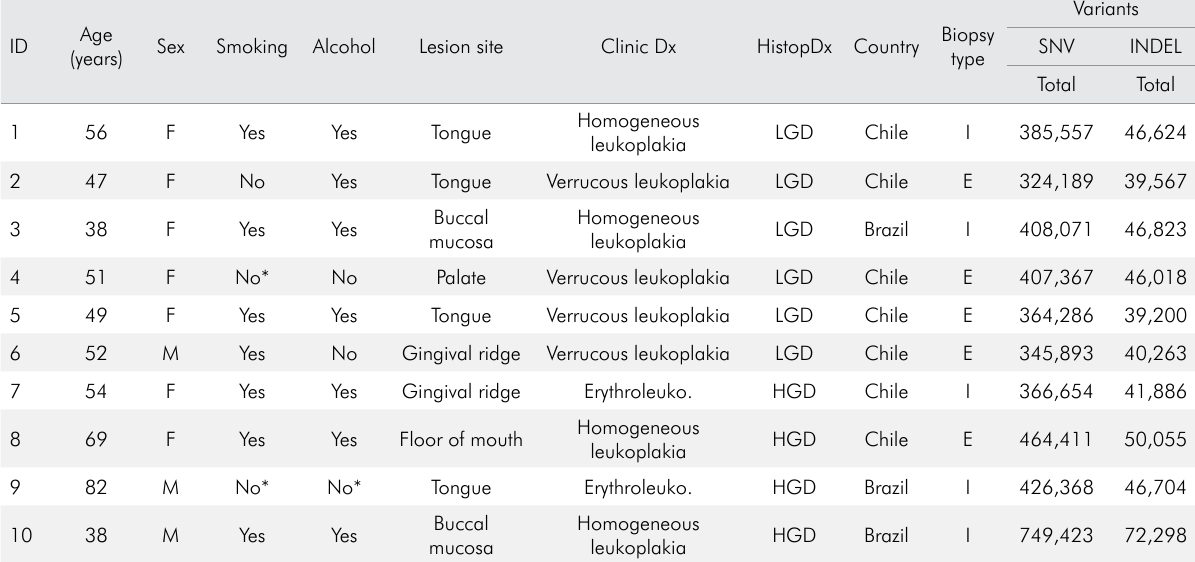
Table. Summary of patient characteristics, histopathological diagnosis, and total variants per sample.